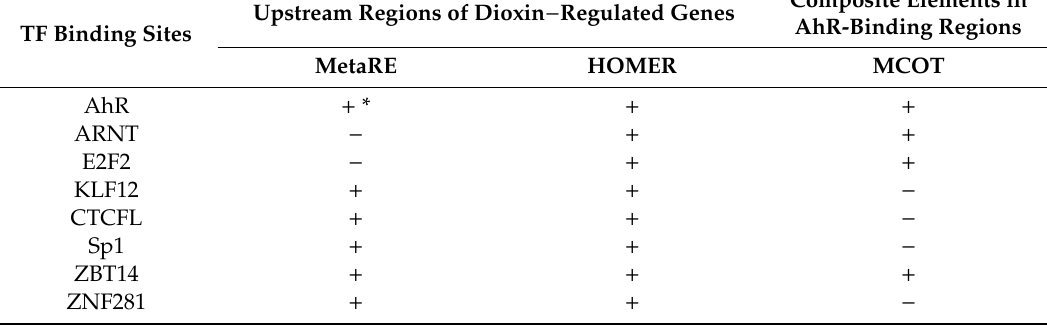
Table 4. Summary table for known and predicted transcriptional regulators of dioxin